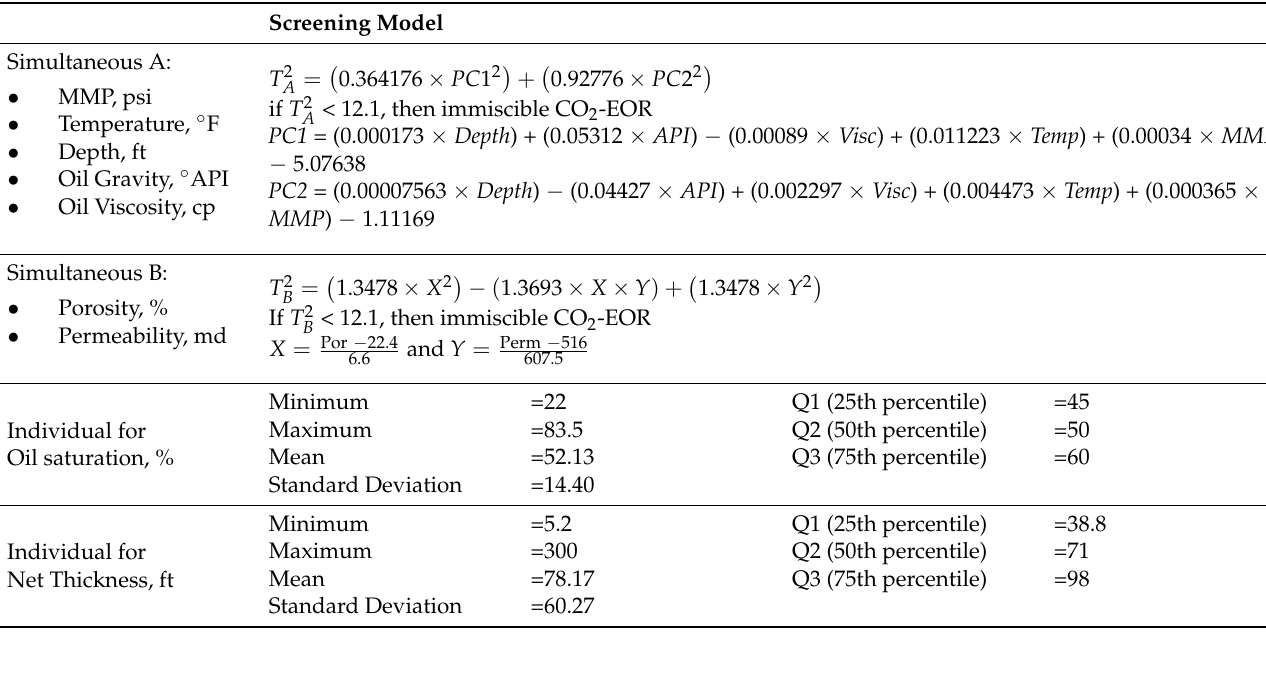
Table 4. Summary of the immiscible CO 2 -EOR screening model.